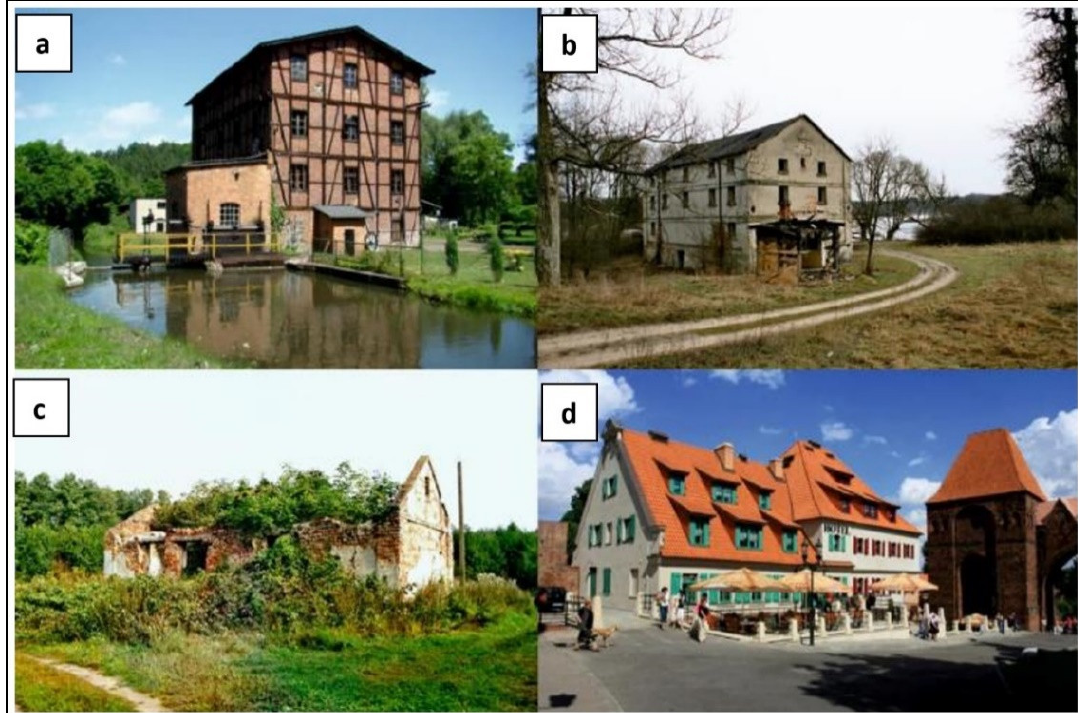
Figure 22. The degree of preservation of water mills at various stages of the evolution of mill-based landscape: ( a ) a mill preserved in its original form and function; ( b ) an abandoned water mill; ( c ) ruins of a water mill; and ( d ) building of a mill converted into a hotel and restaurant (adapted from [56]).